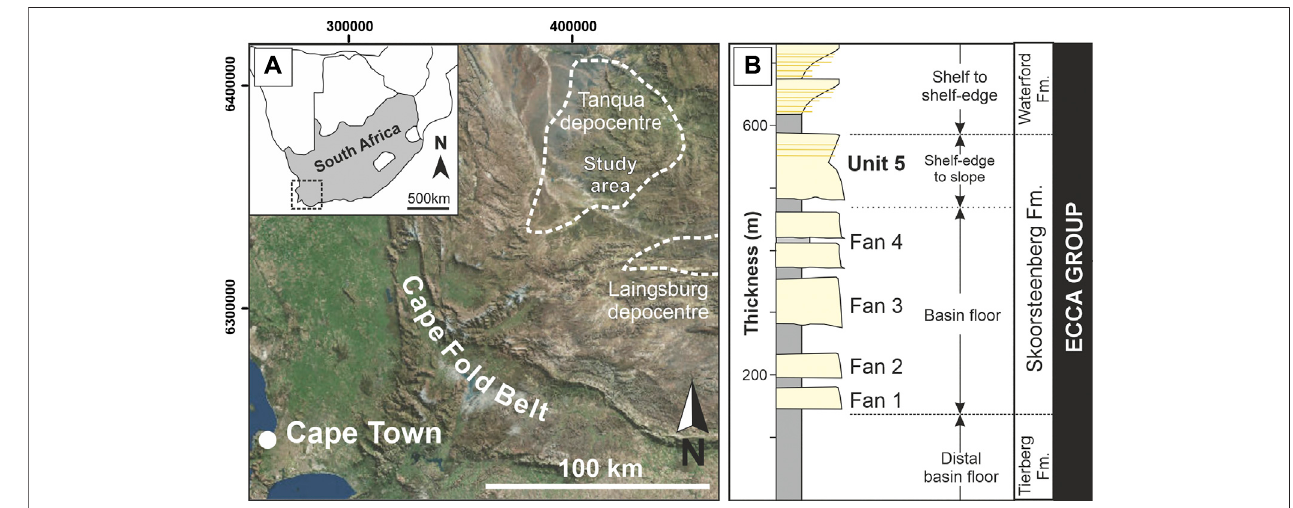
FIGURE 1 | (A) The southwestern Karoo Basin with the Tanqua depocentre and the study area outlined. (B) A summary of the Ecca Group stratigraphy modi fi ed from Hodgson et al. (2006), Prélat et al. (2009).